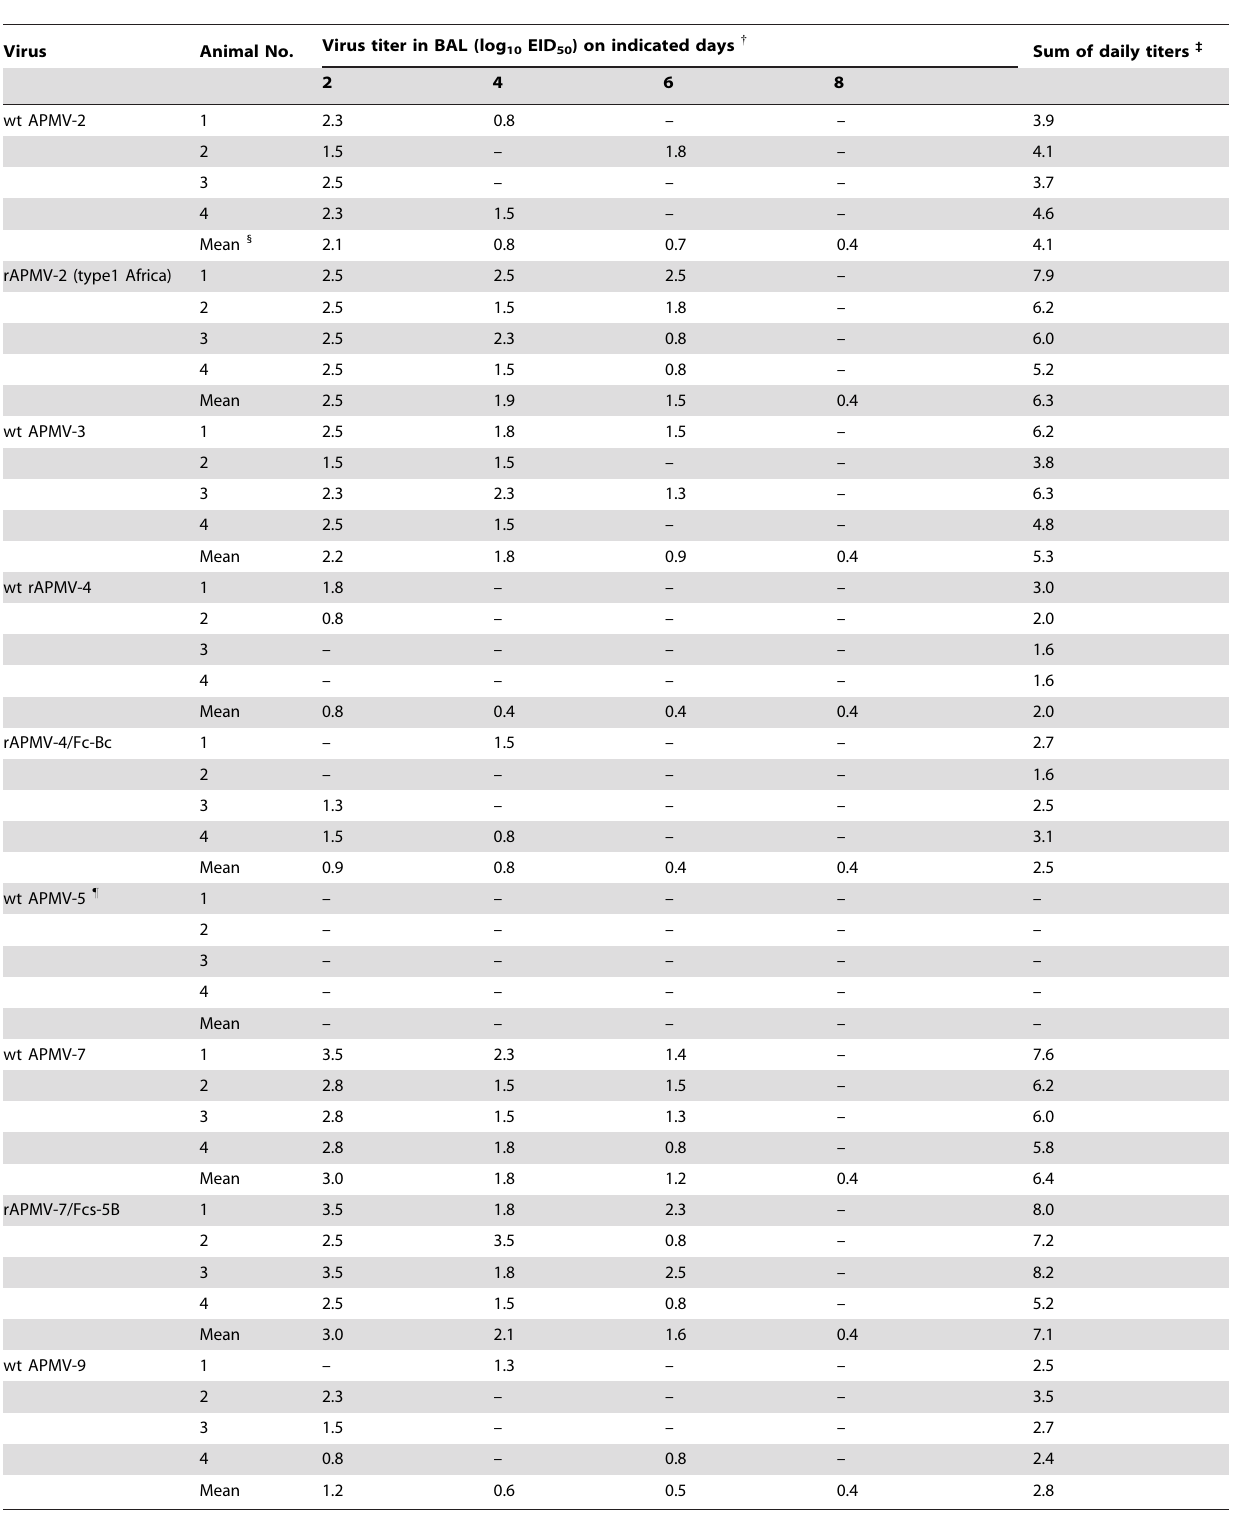
Table 3. Detection of the indicated APMV strains from the lower respiratory tract of rhesus macaques. *